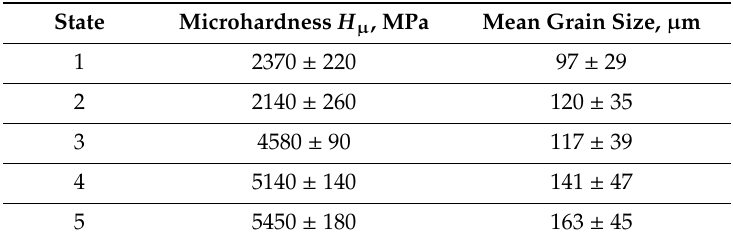
Table 4. Effect of Rolling Reduction on Microhardness and Grain Size. Table 4. E ff ect of Rolling Reduction on Microhardness and Grain Size.